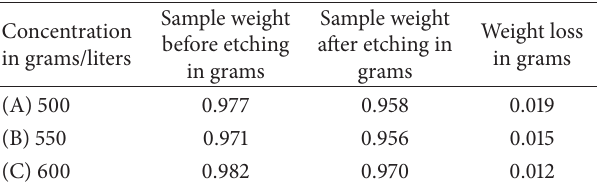
Table 4: Summary of ANOVA for surface